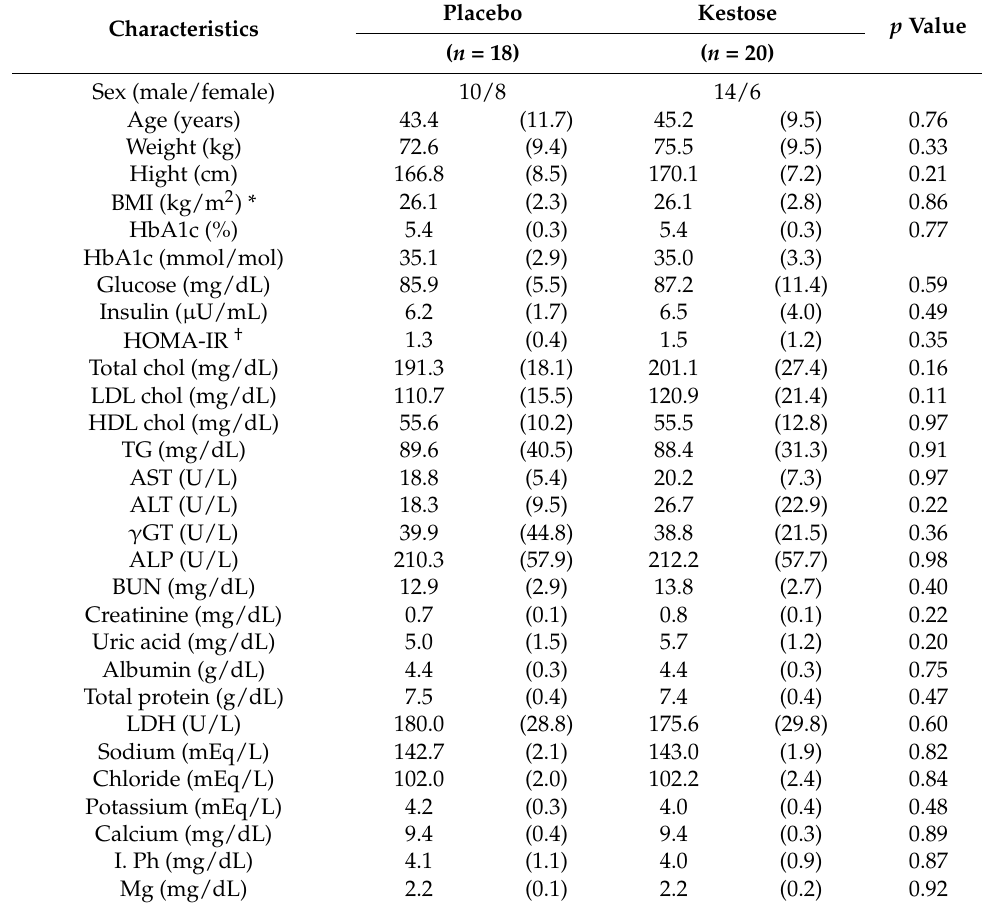
Table 1. Baseline